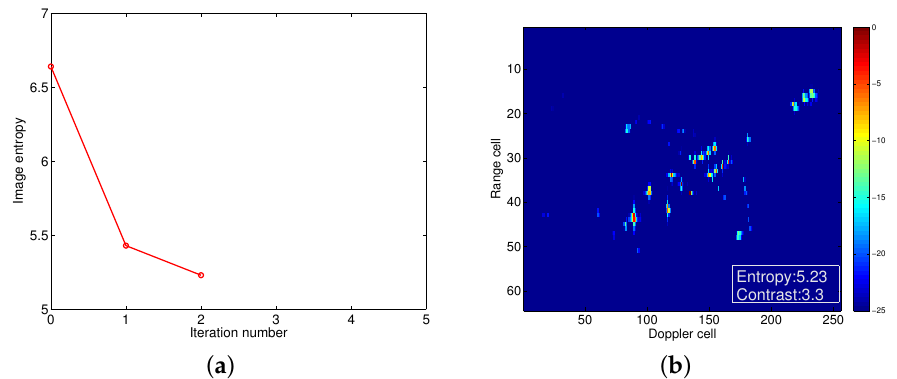
Figure 10. Experimental results using the new imaging approach. ( a ) Variation of the image entropy. ( b ) ISAR image based on the new imaging